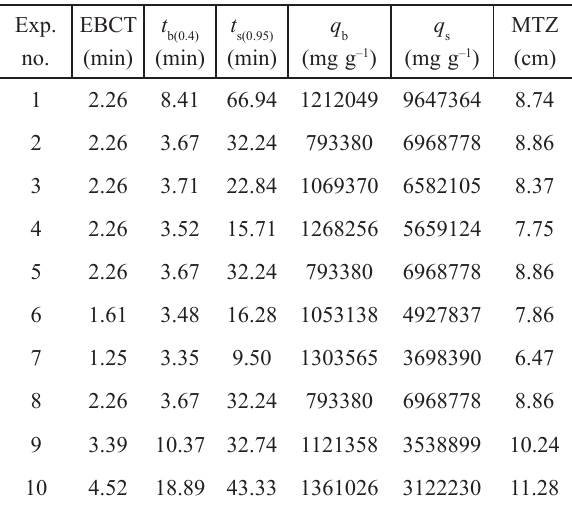
Table 3 – Adsorption data for acrylic acid adsorption onto CaO nanoparticles in a fixed bed column at different process 2 conditions Exp.